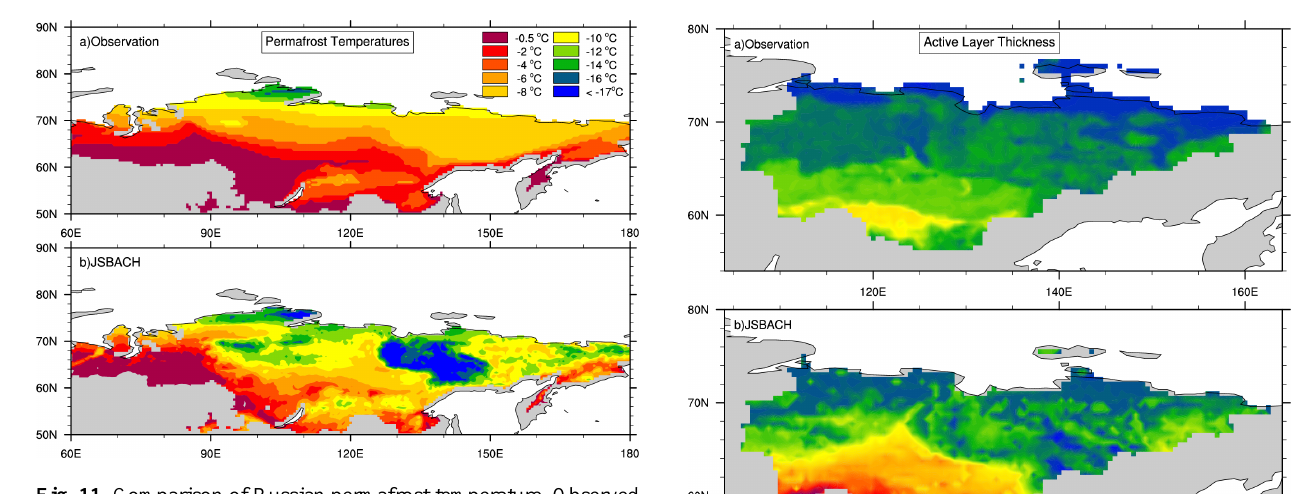
Fig. 11. Comparison of Russian permafrost temperature. Observed (map a ; see text for more details) (Land Resources of Russia CD- ROM, 2002) and simulated (map b ) Russian permafrost tempera- ture during the period 1960–1990. The average values in different temperature classes are plotted with the same color in both maps.